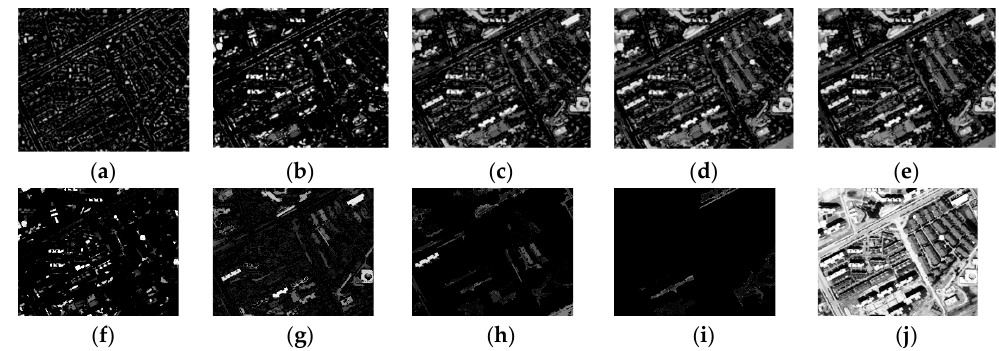
Figure 2. The attribute profiles (APs) and differential attribute profiles (DAPs) obtained by attribute ld on threshold 10,30,50,70, and 90. The example grayscale image is in Figure 4j. ( a – e ) are the opening profiles obtained on threshold 10,30,50,70, and 90, respectively. ( f – i ) are the DAPs obtained between adjacent scales.